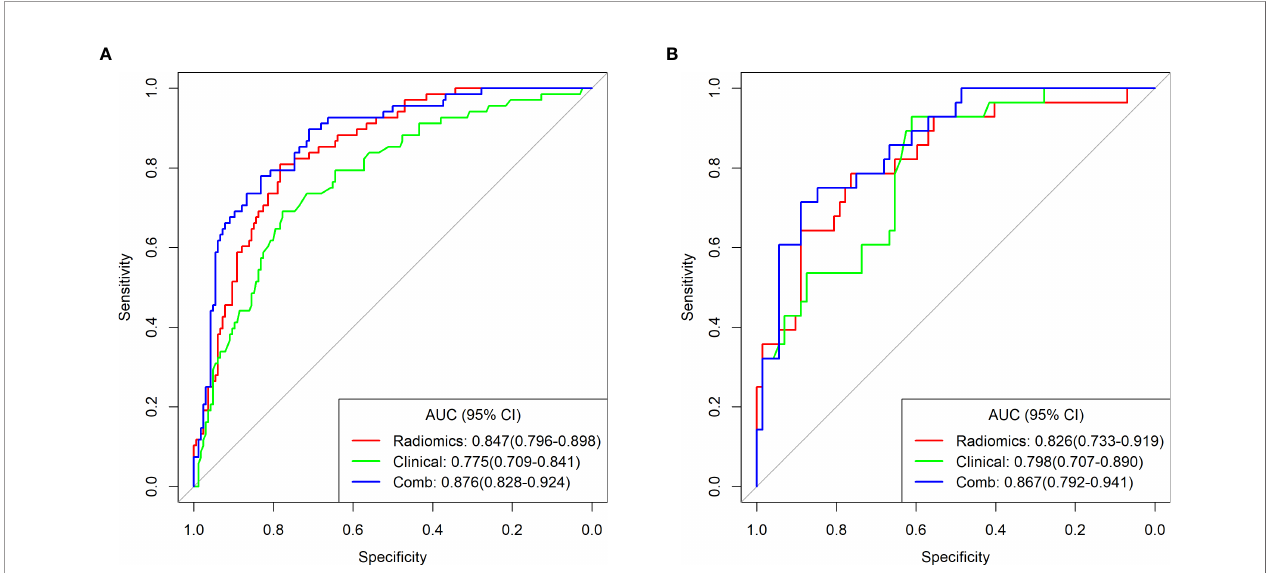
FIGURE 3 | ROC curves of the radiomics, clinical and combined models for predicting LVI in the training cohort (A) and testing cohort (B) .